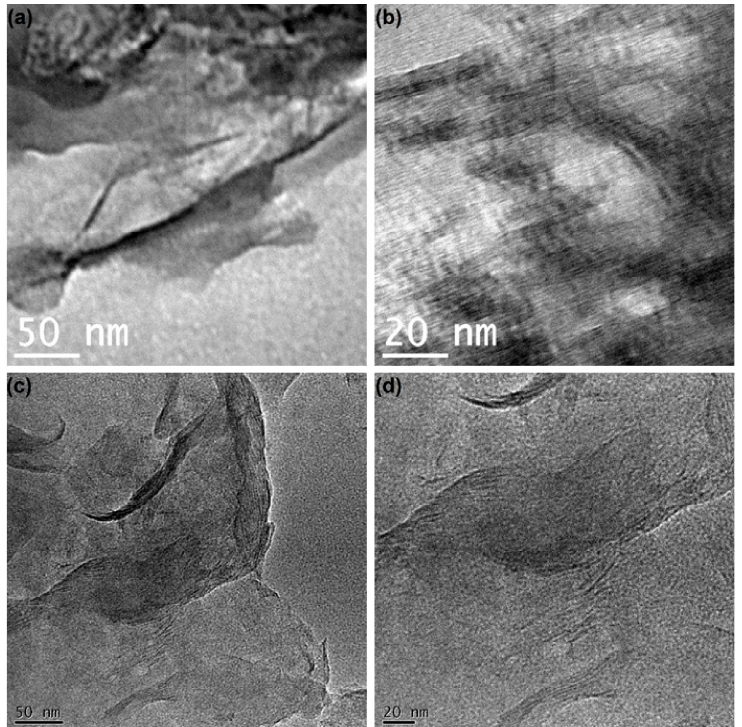
Figure 2. TEM micrographs of natural and modified BClay:( a ) natural BClay 50 nm; ( b ) natural BClay 20 nm; ( c ) modified BClay 50 nm, and ( d ) modified BClay 20 nm.